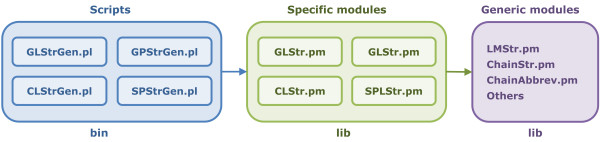
Software architecture of the LipidMapsTools package. The command line scripts make use of the specific module to generate virtual compound libraries, which in turn access the functionality from the generic modules to draw structures and generate additional ontological information such as abbreviation, systematic name, etc.